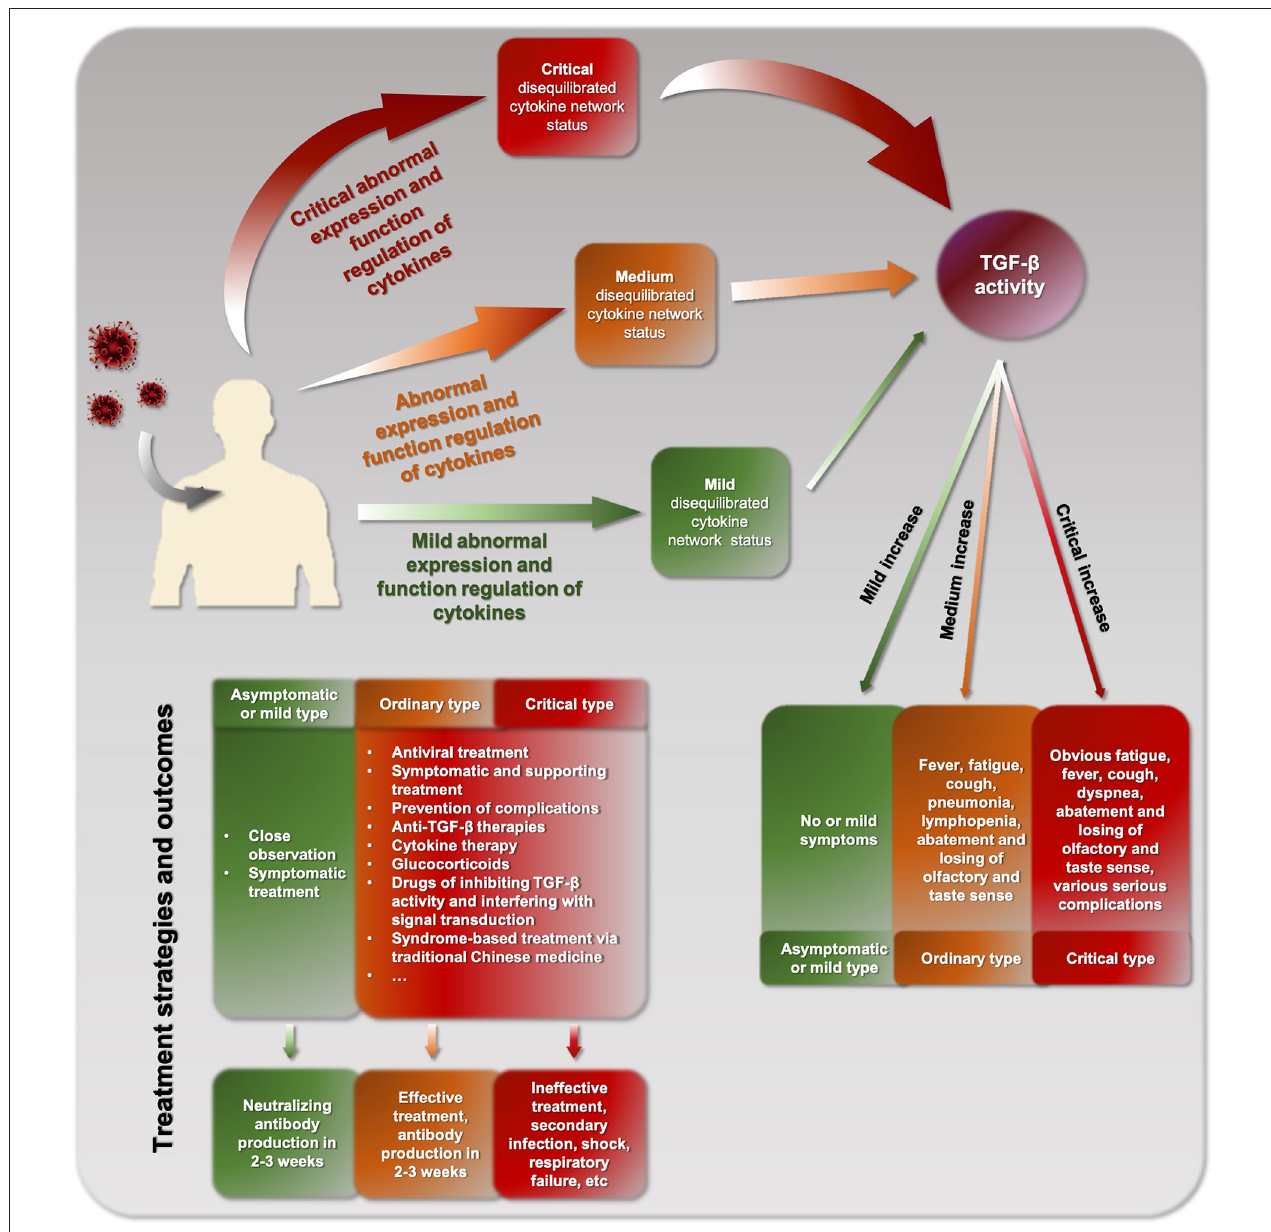
FIGURE 2 | The overall pathogenic process and cytokine storm of COVID-19.